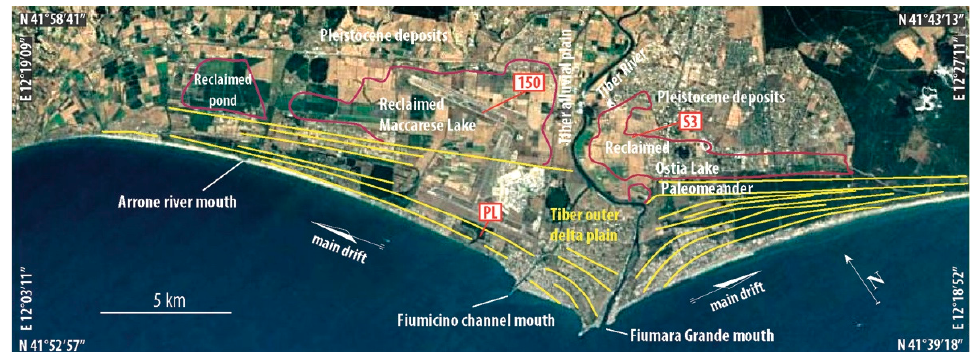
Figure 6. Morphological scheme of the Tiber delta area. The yellow lines indicate the trend of the Holocene beach/dune ridges. The red line indicates the outline of the marshes/ponds reclaimed between the 19th and 20th centuries. The labels in the white rectangles indicate the location of the boreholes, shown in Figure 7 (Image Landsat/Copernicus–Google Earth).